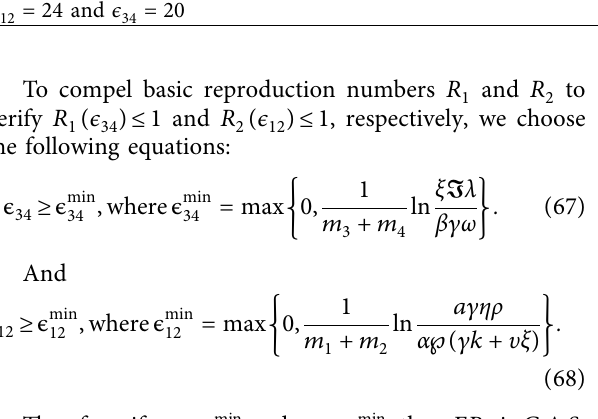
Table 3: Te variation of R